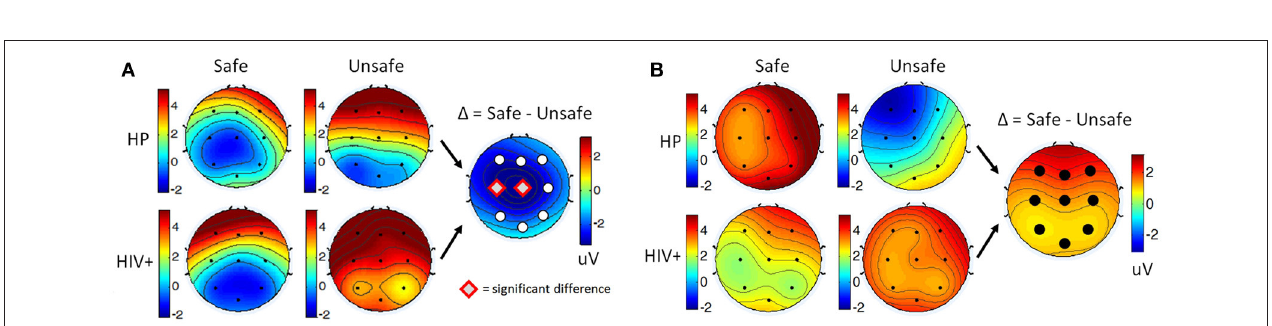
FIGURE 7 | Topographical maps of (A) the average P200 component in Non-Target ERP trials (left panel) and (B) average LPP component in Target trials (right panel) plotted for all subgroups: Safe/HP, Safe/HIV + , Unsafe/HP and Unsafe/HIV + . In each panel, the difference plot between total Safe and Unsafe groups is shown on the right side. Channels with significant differences between the two groups ( t -test, p < 0.05) are marked with a diamond